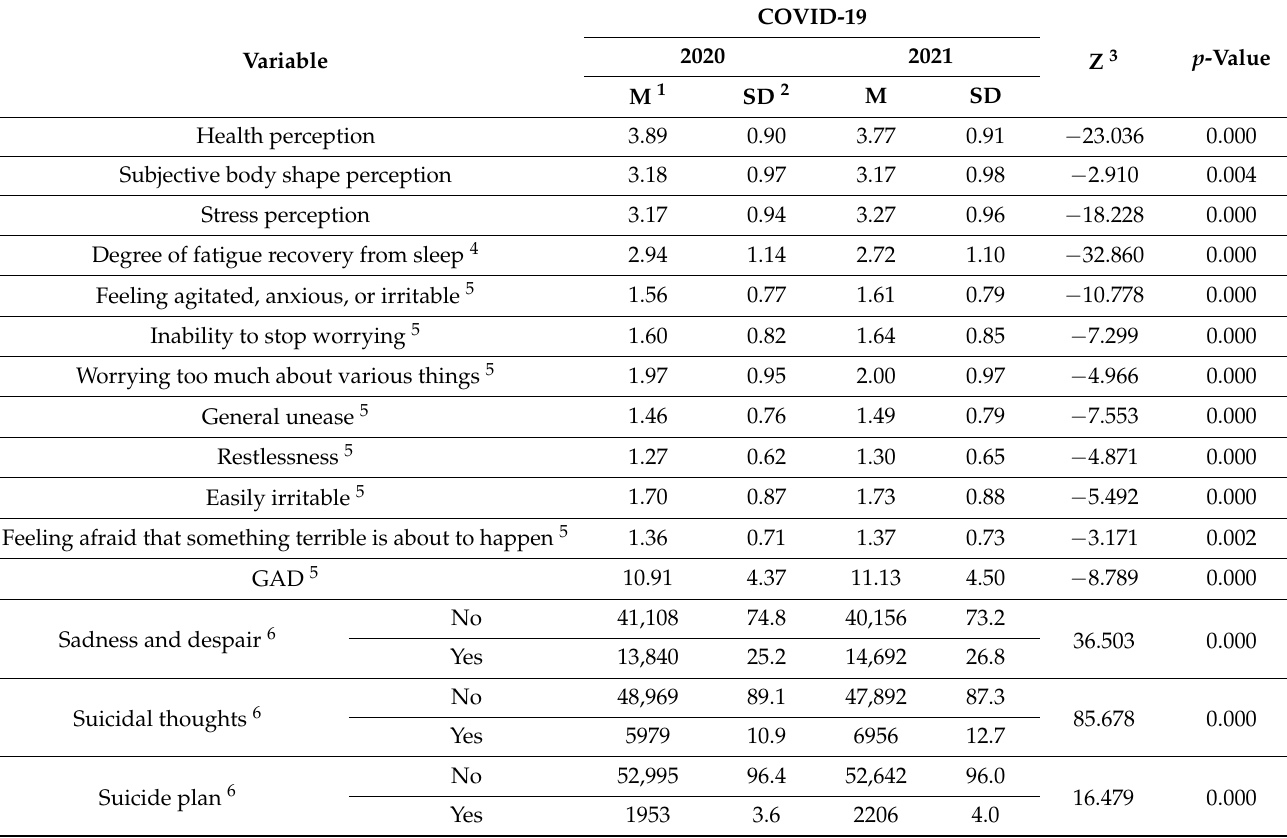
Table 2. Emotional and cognitive changes in the first and second years of the COVID-19